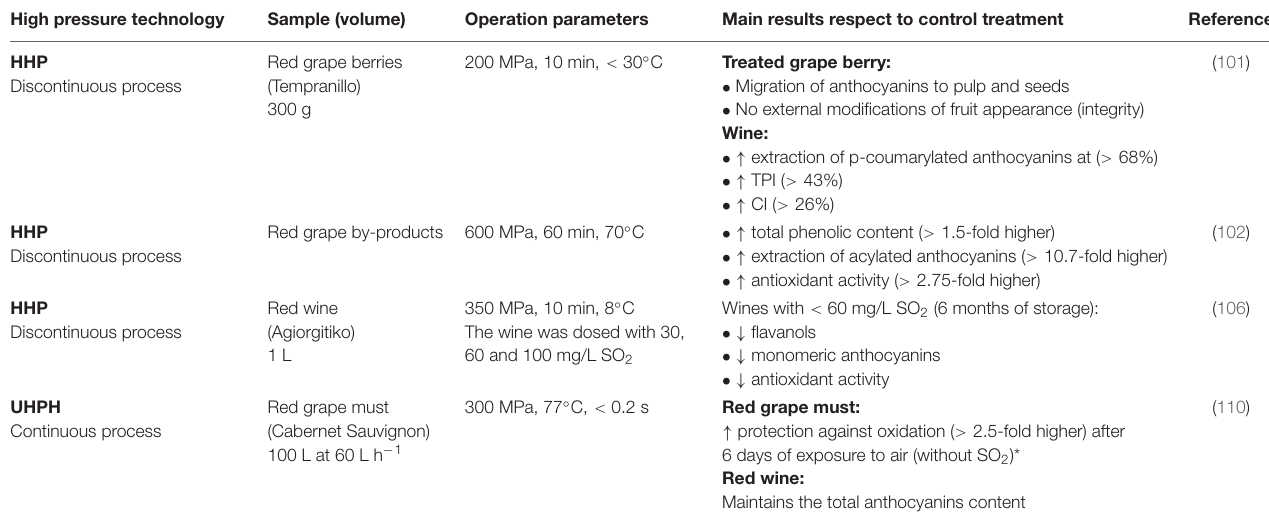
*Oxidative process: monitored by the evolution of the hue (evolution from red-blue to red-brown tonalities).